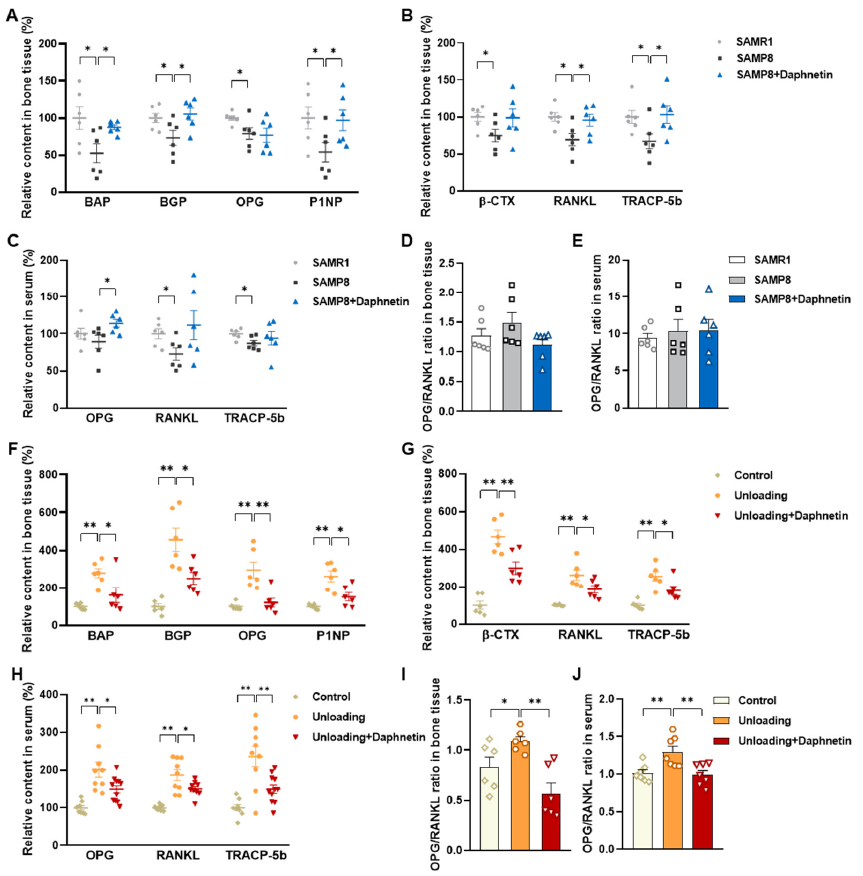
Figure 3. Effects of daphnetin on bone turnover status and OPG/RANKL pathway in SAMP8 and hindlimb unloading mice. In SAMP8 mice, the relative content of bone formation-related parameters ( A ), bone resorption-related parameters ( B ), and OPG/RANKL ratio in bone homogenates ( D ) were determined by ELISA. Serum levels of OPG, RANKL, and TRACP-5b ( C ), as well as OPG/RANKL ratio in serum ( E ) were also determined. In hindlimb unloading mice, the relative content of bone formation-related parameters ( F ), bone resorption-related parameters ( G ), and OPG/RANKL ratio in bone homogenates ( I ) were determined by ELISA. Serum levels of OPG, RANKL, and TRACP-5b ( H ), as well as OPG/RANKL ratio in serum ( J ) were also determined. Data are mean ±S.E.M. ( n ≥ 6); * p < 0.05; ** p < 0.01.